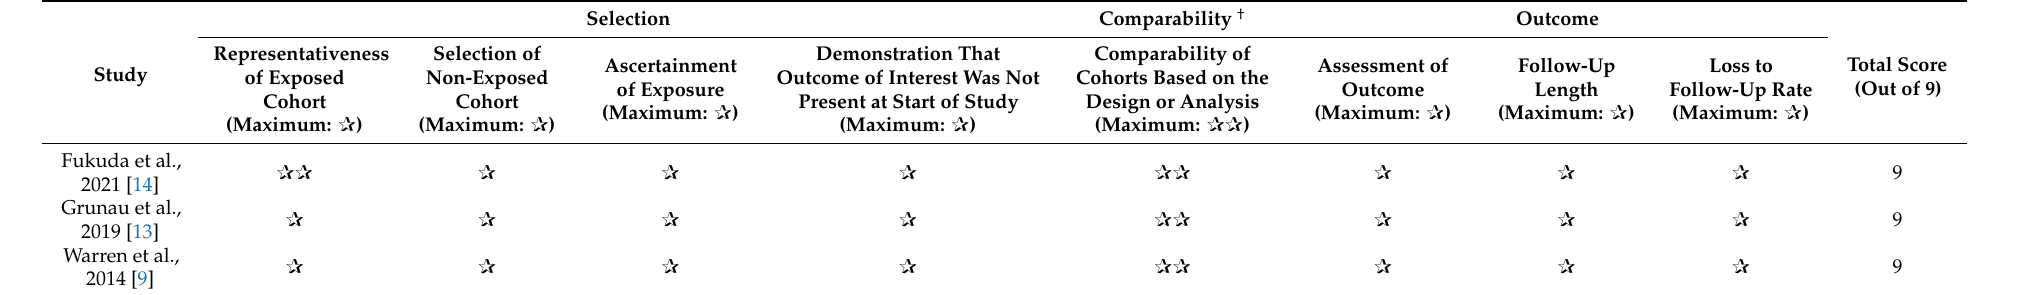
Table 2. Quality assessment using the Newcastle-Ottawa scale of included